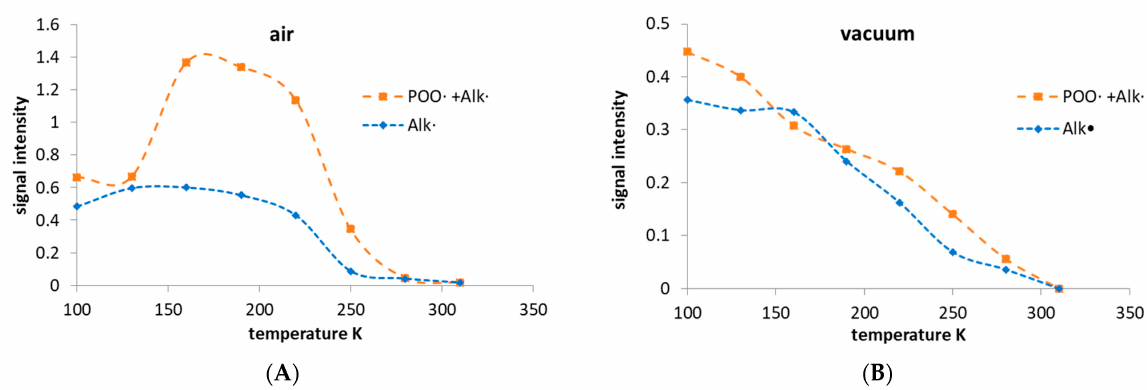
Figure 4. Intensities of the (POO • + Alk • ) and Alk • signal components in AO-unprotected, unaged XLPE probe-irradiated in air ( A ) and vacuum ( B ), in different temperatures at measurement. Dashed lines are guides for the